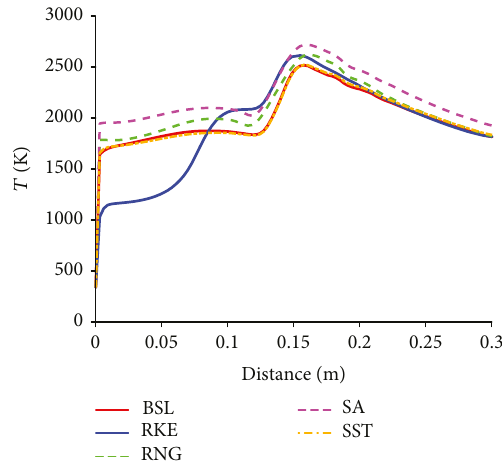
Figure 9: Static temperature along the central axis of the